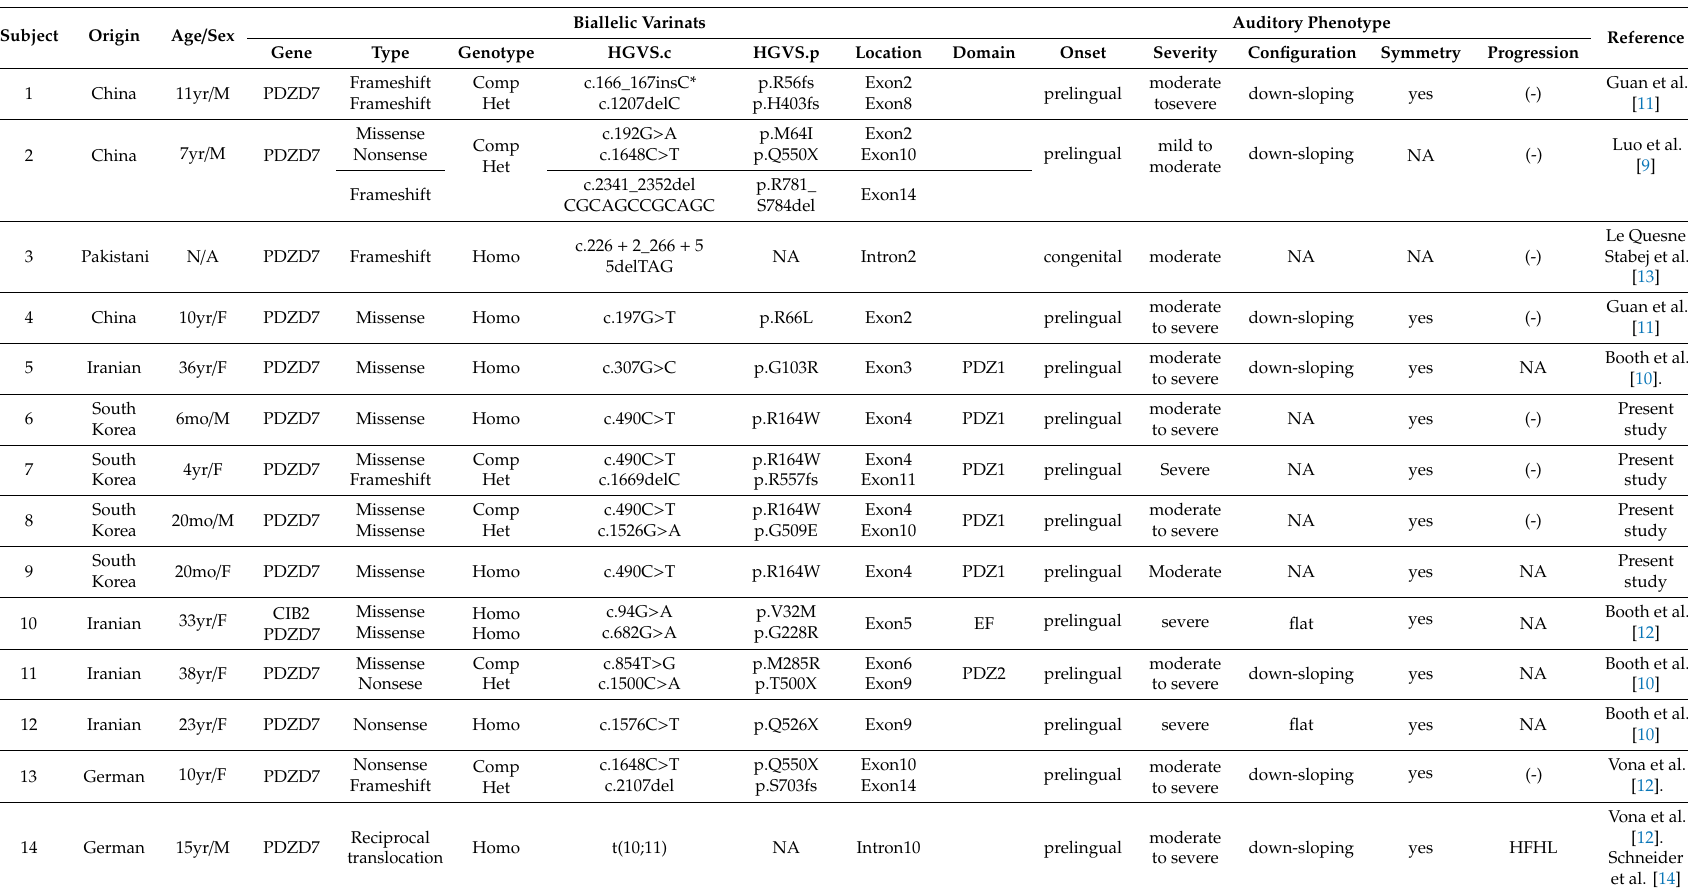
Table 2. A systematic review of auditory profiles in subjects with PDZD7 biallelic